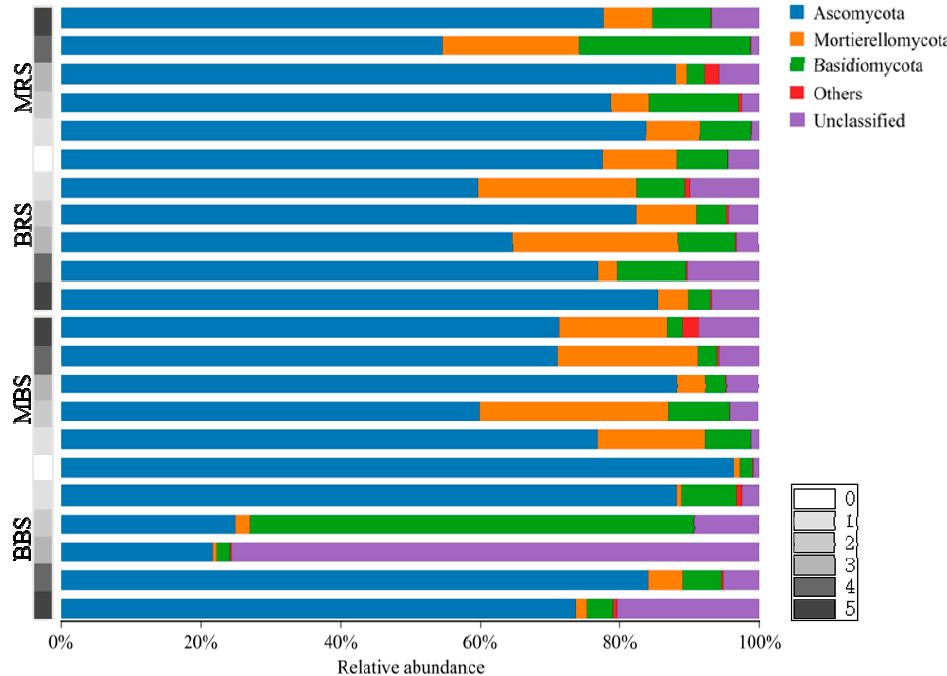
Figure 4. The levels of relative fungal abundance of each phylum. Taxa with less than 1% of the total number of sequences are depicted in “other.” B and M indicate bamboo biochar and bacteria-inoculated biochar; BS and RS indicate bulk soil and rhizosphere soil. 0, 1, 2, 3, 4, and 5 indicate control, 2.22 t · ha − 1